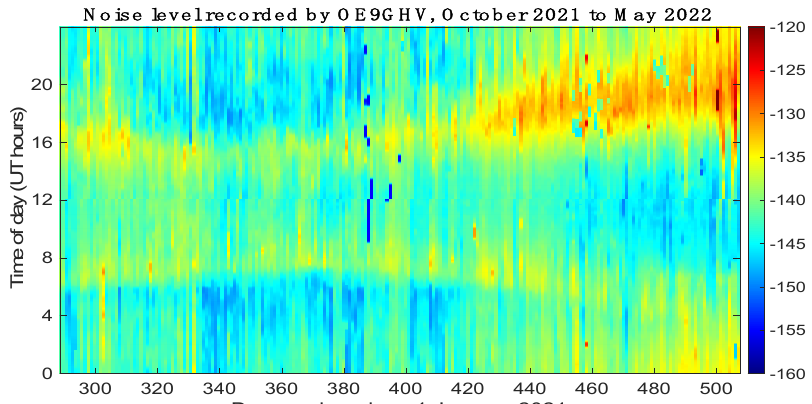
Figure 18. Noise level measurements from a 7 MHz radio receiver in Austria with a callsign OE9GHV. The colour bar indicates the radio noise level in dBm/Hz. The x-axis indicates the day of the year, and the y-axis indicates the time of day, from 17 October 2011 to 21 May 2022, [12].